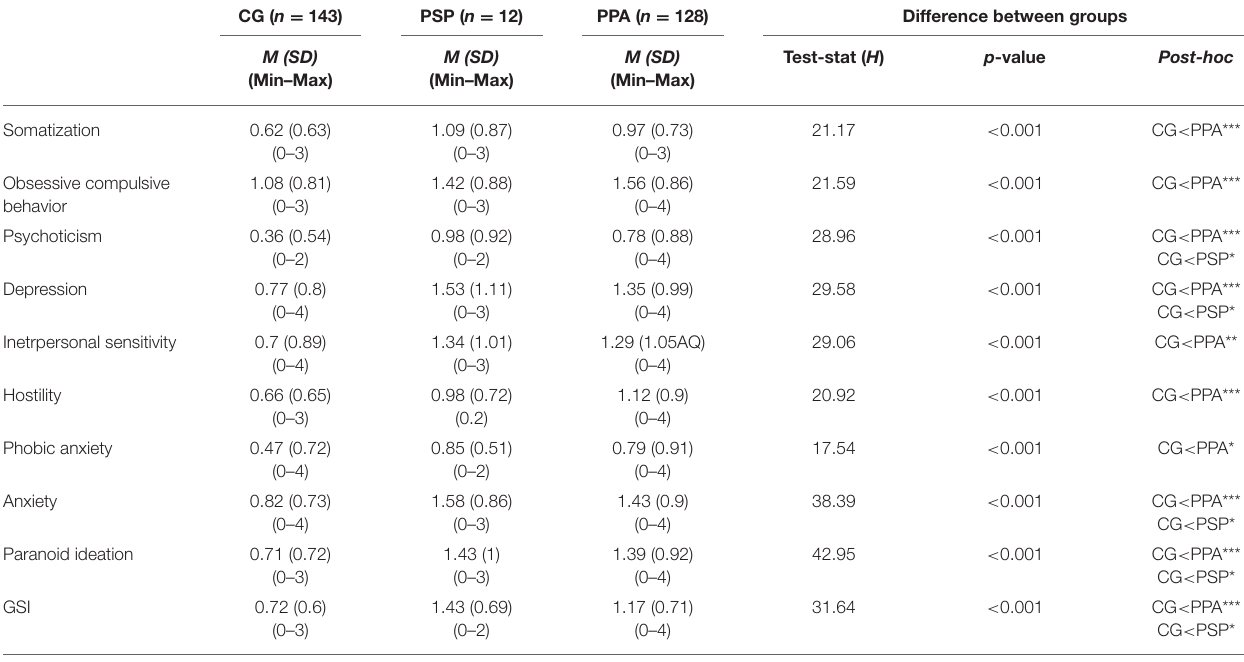
TABLE 3 | Self-reported psychiatric distress level in a sample of Swedish adolescent’s according to psychosocial variable groups.